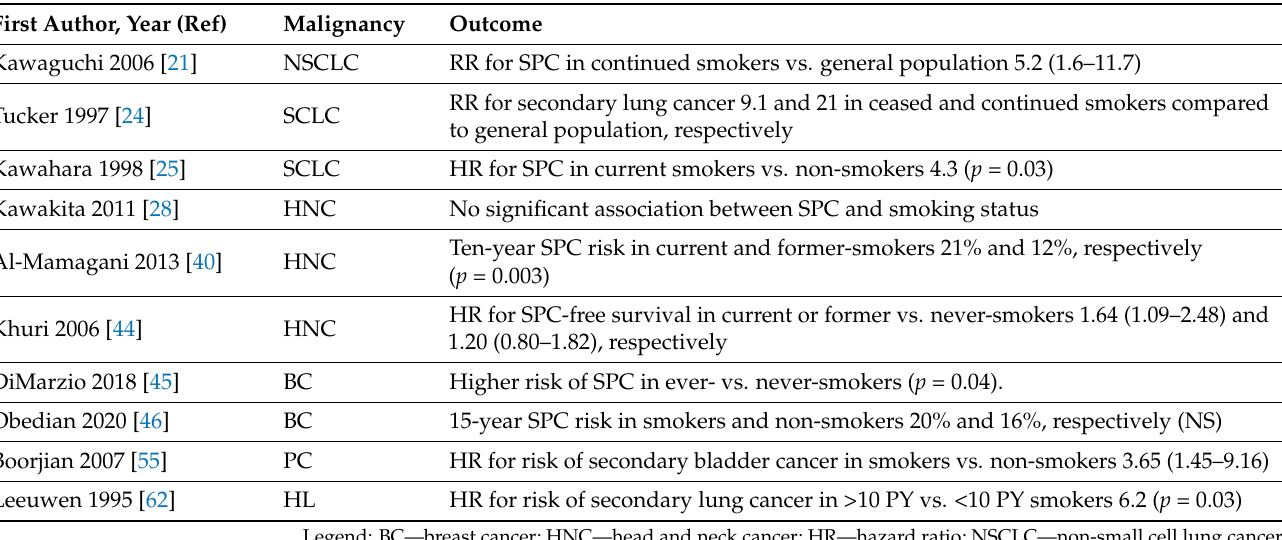
Table 4. Impact of tobacco smoking on risk of developing second primary cancer.